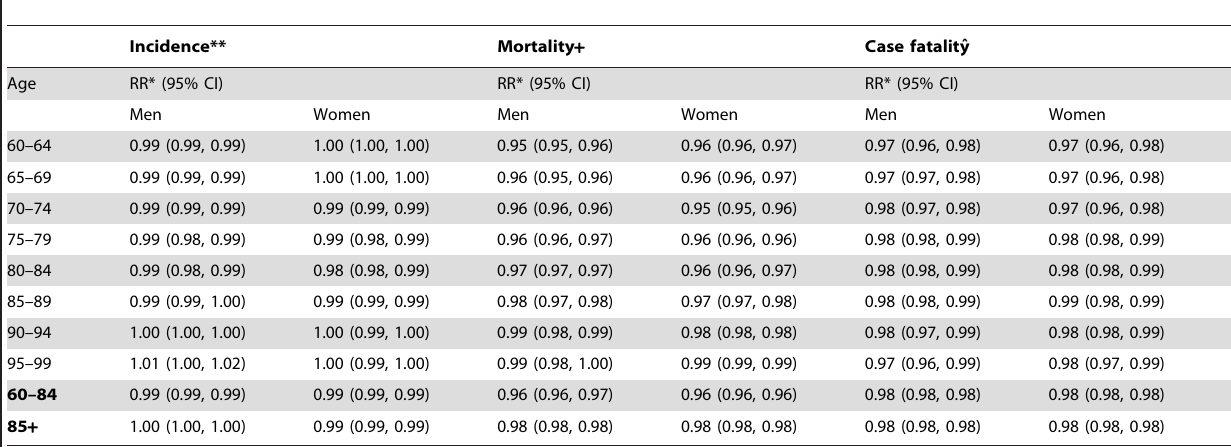
Table 3. Average annual change in stroke between 1994 and 2010, ages 60–99 years, men and women.